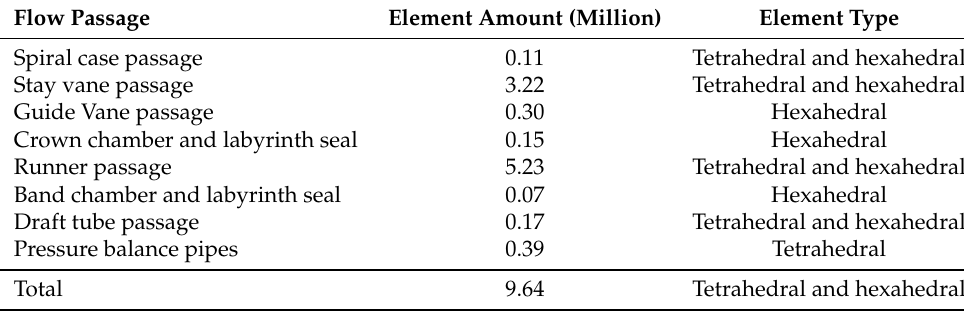
Table 3. Element amount of different PT flow passages.